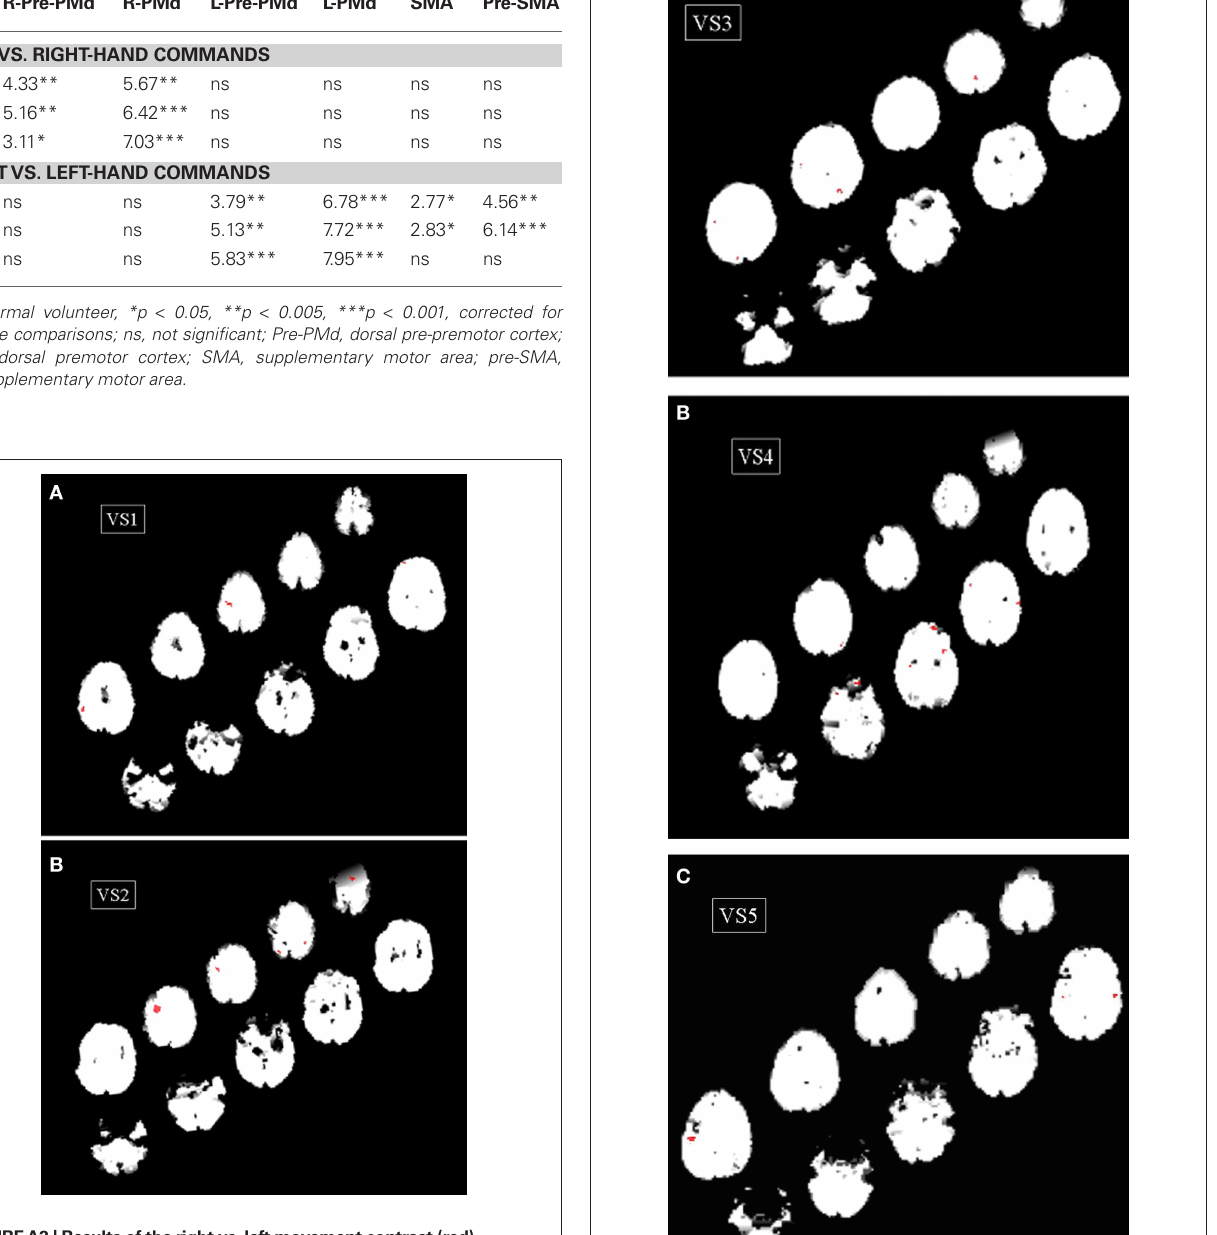
Frontiers in Human